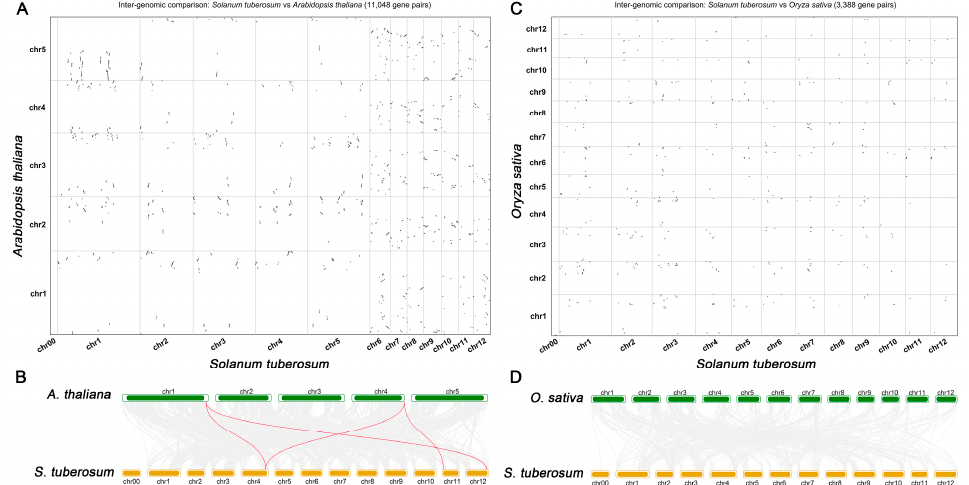
Figure 5. Analysis of synteny relationships. ( A , C ) Dot plots representations of the intergenomic comparison relationships between potato and other species. The dots represent synteny genes, and the abscissa and ordinate represent the number of chromosomes of different species. ( B , D ) Synteny analysis between potato and other species of the SnRK2 gene family. Two species (Arabidopsis and rice) were compared with potato SnRK2 genes. Gray lines represent the collinear blocks within the genomes, whereas the red lines highlight the syntenic SnRK2 gene pairs.